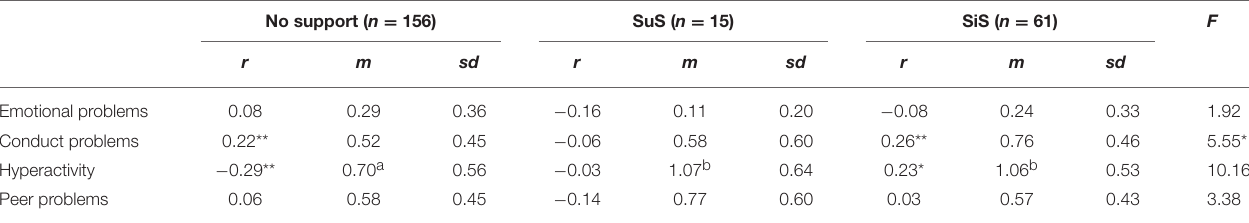
TABLE 3 | Pearson correlations and comparison of behavior difficulties on support